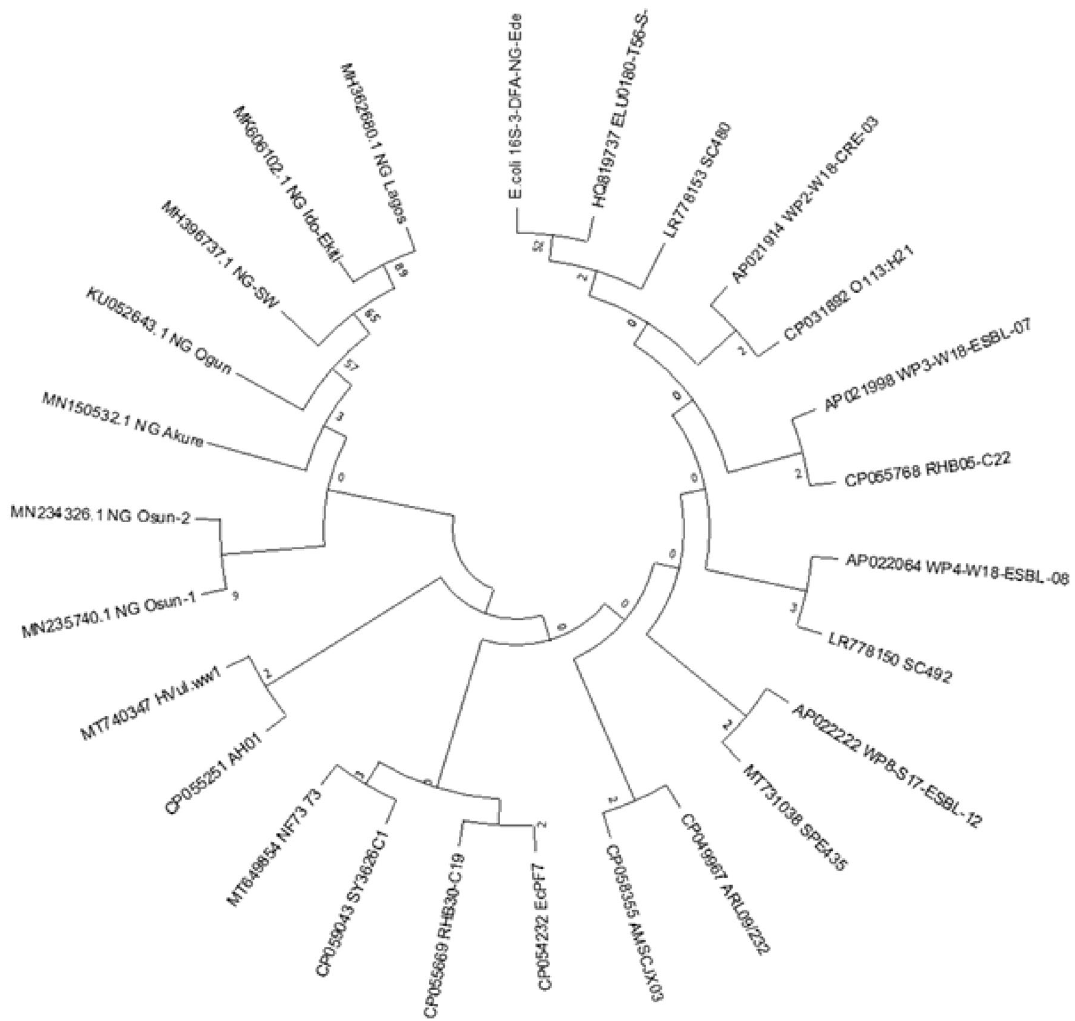
Figure 3. Phylogenetic analysis of E. coli sequence from Beef abattoir compared with publicly available sequences. Evolutionary analyses and phylogenetic tree were conducted in MEGA X version 7 (https:// www. megas oftwa re.